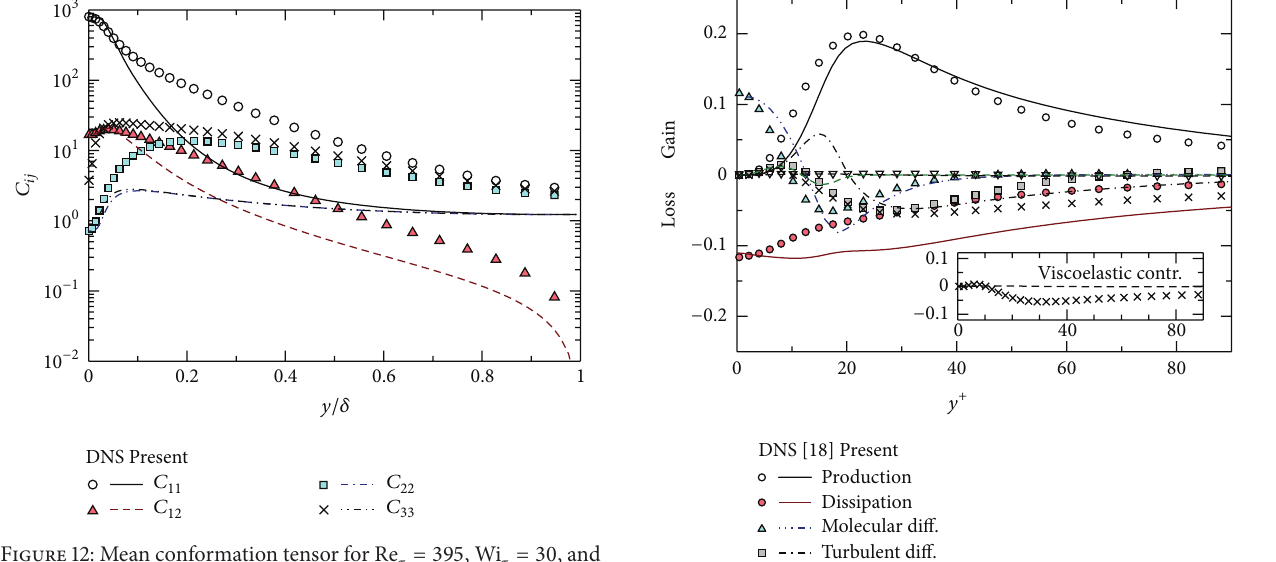
Figure 12: Mean conformation tensor for Re 𝜏 = 395 , Wi 𝜏 = 30 , and 𝛽 = 0.5 .